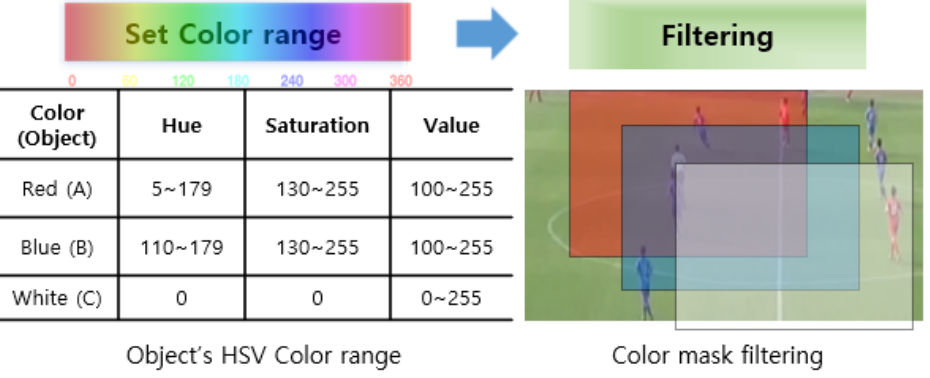
Figure 9. The object’s HSV color mask process.